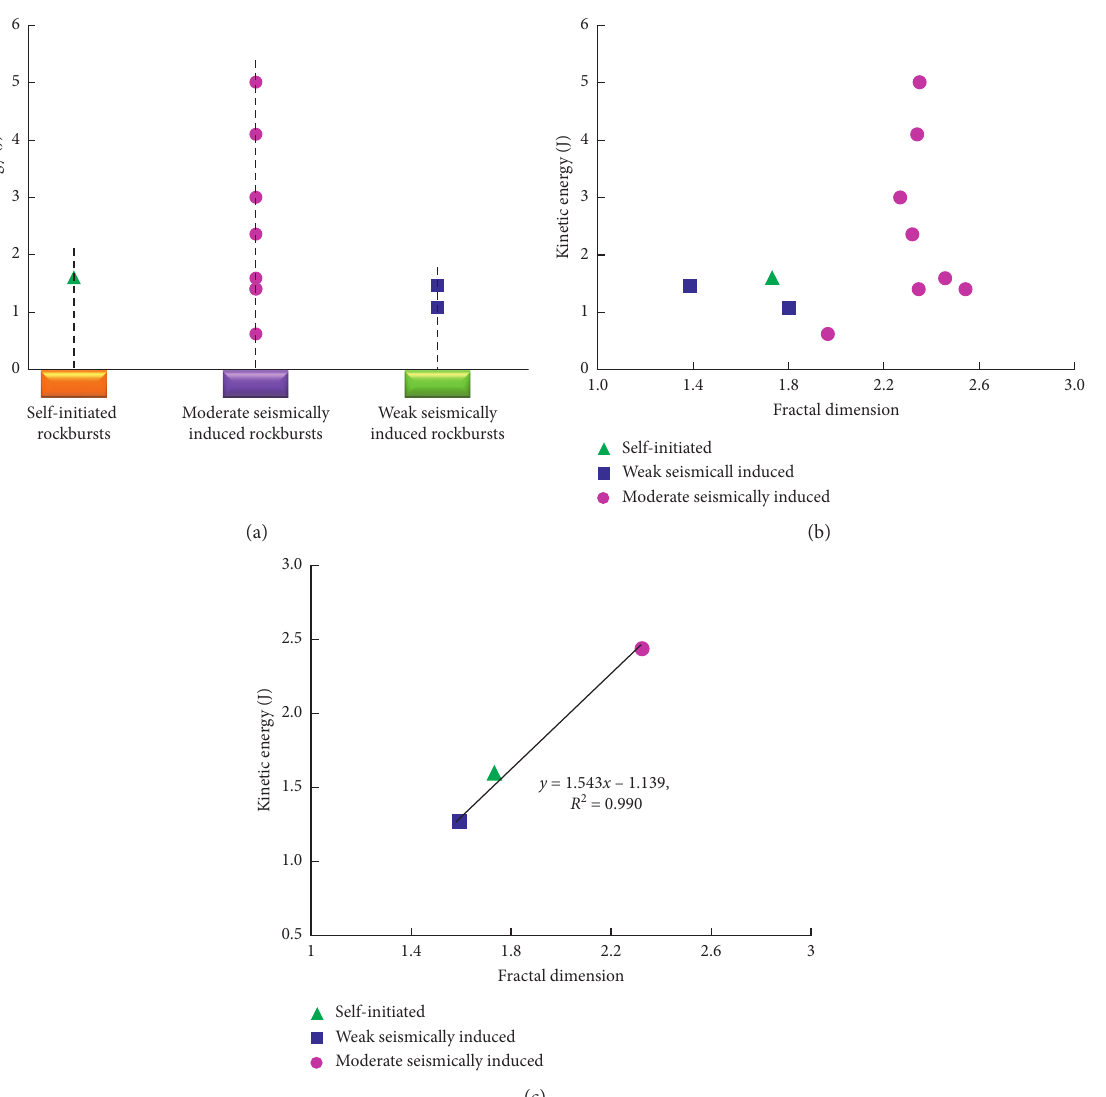
Figure 13: Kinetic energy and relationship between fractal dimension and kinetic energy of different types of rockbursts: (a) kinetic energy, (b) scatter plots of fractal dimension and kinetic energy, and (c) linear relationship between the averaged fractal dimension and kinetic